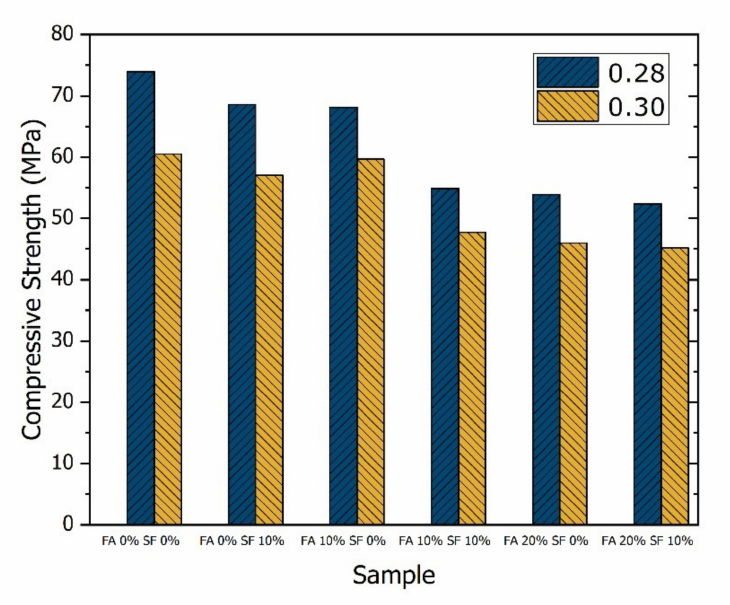
Figure 5. Compressive strength of the 12 HPC samples at day 28 with a water/binder (W/B) ratio of 0.28 or